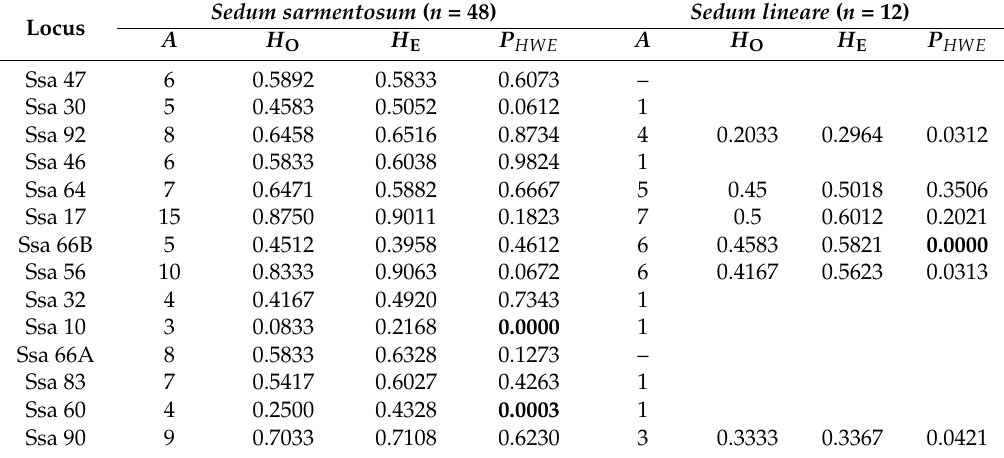
Table 2. Genetic diversity of microsatellite marker for S. sarmentosum and S. lineare .